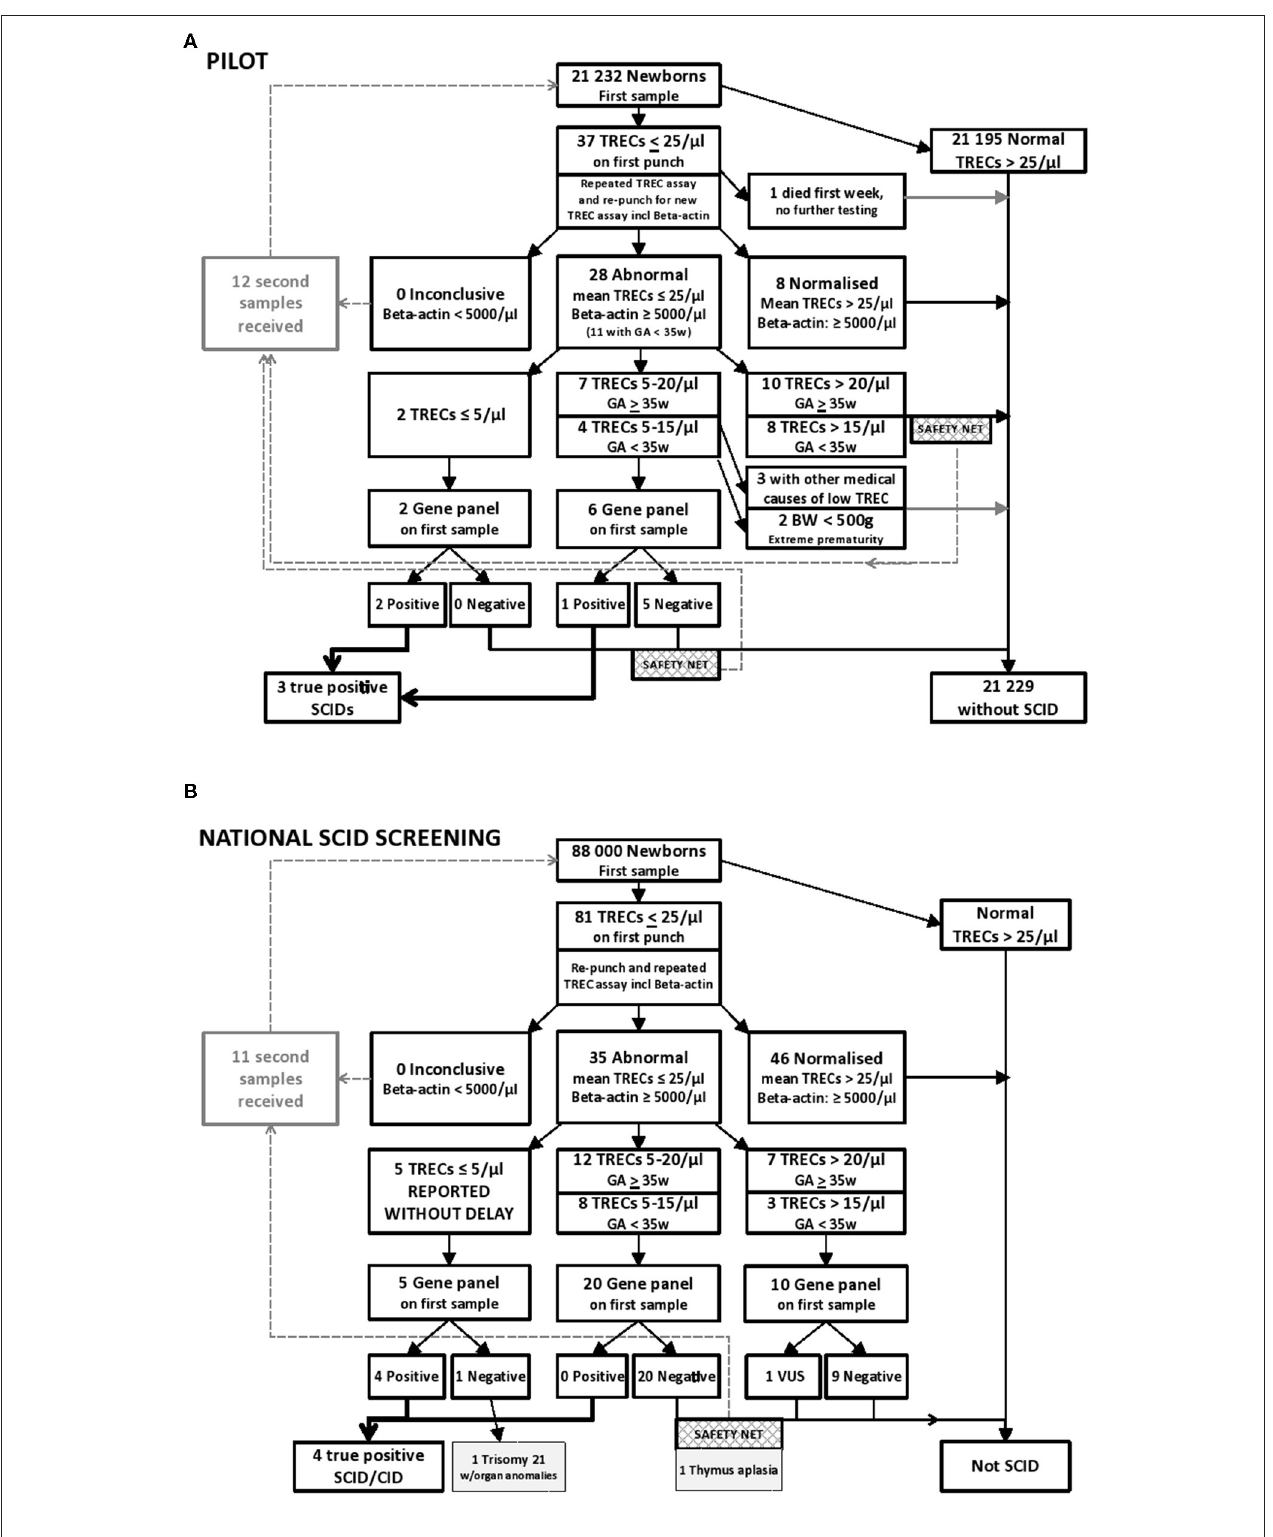
FIGURE 1 | (A) Results from the prospective pilot study with NGS gene panel testing integrated in the NBS laboratory algorithm for SCID and other T cell lymphopenias. Samples below 25 TRECs/ µ L were re-run and re-punched for one new TREC analysis. Samples with normal levels of β -actin ( ≥ 5,000/ µ L) and mean